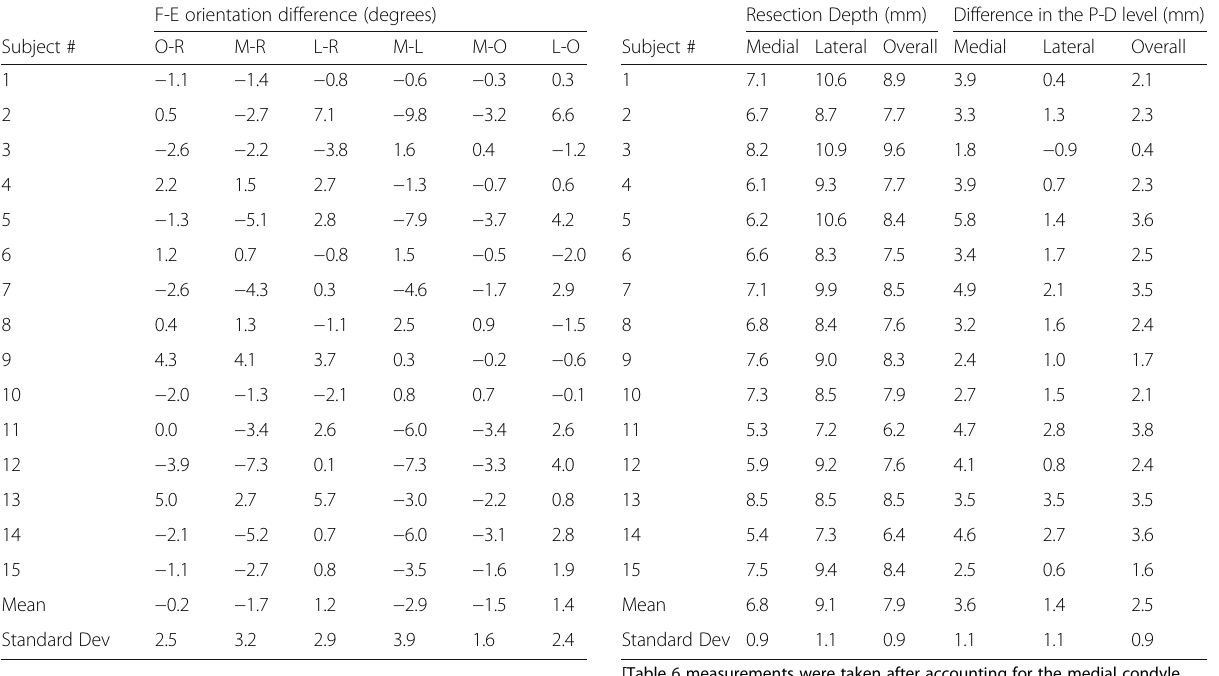
Table 6 Resection depth and difference in the P-D level for 15 patients (in